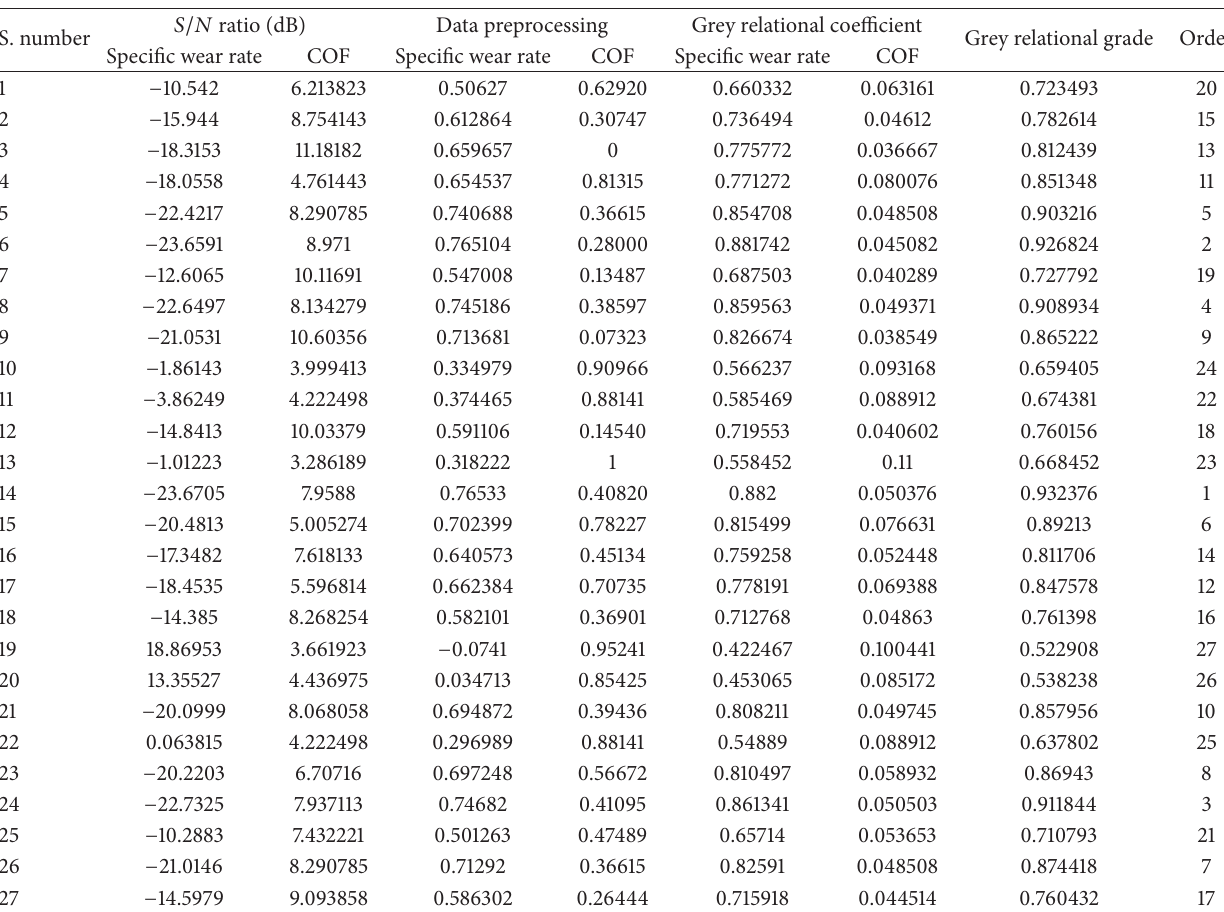
Table 2: Grey relational analysis.